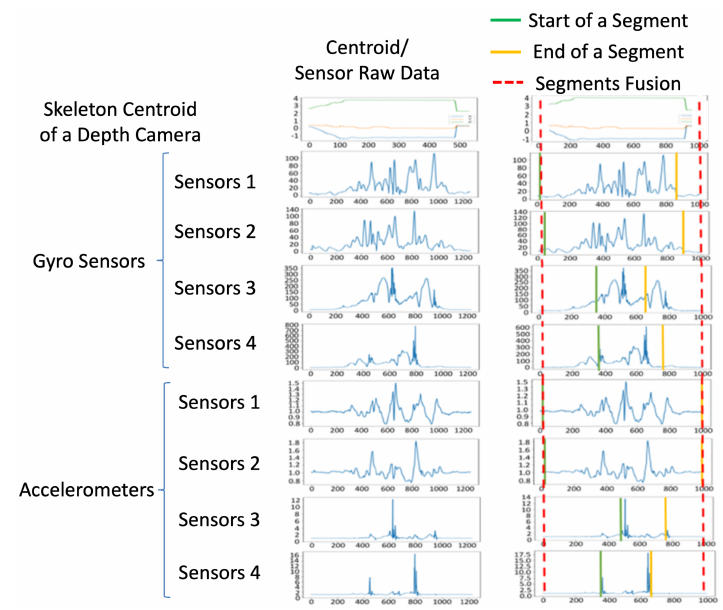
Figure 4. Segmentation fusion: raw data of the sensing signals from multiple sensors are on the left, and the resampled data are on the